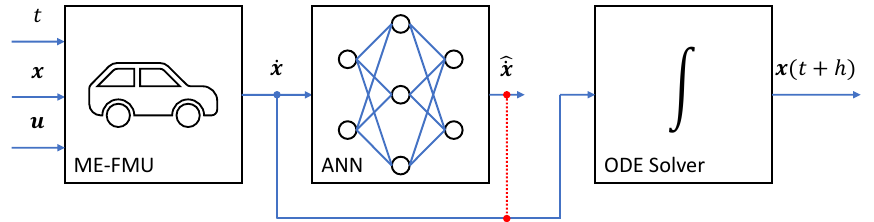
Figure 5. For NIPT, a single reference simulation with an unchanged ˙ x is performed to calculate the ANN output ˆ ˙ x ( t ) for every system state x ( t ) . Based on the recorded ANN inputs ˙ x ( t ) and outputs ˆ˙ x ( t ) , the actual pre-training can be performed. As soon as the training goal ˙ x ≈ ˆ˙ x (red-dotted) is reached, the NeuralFMU dynamics equal the dynamics of the FMU itself, which results in the same solution for both. In this case, the ANN’s behavior is neutral